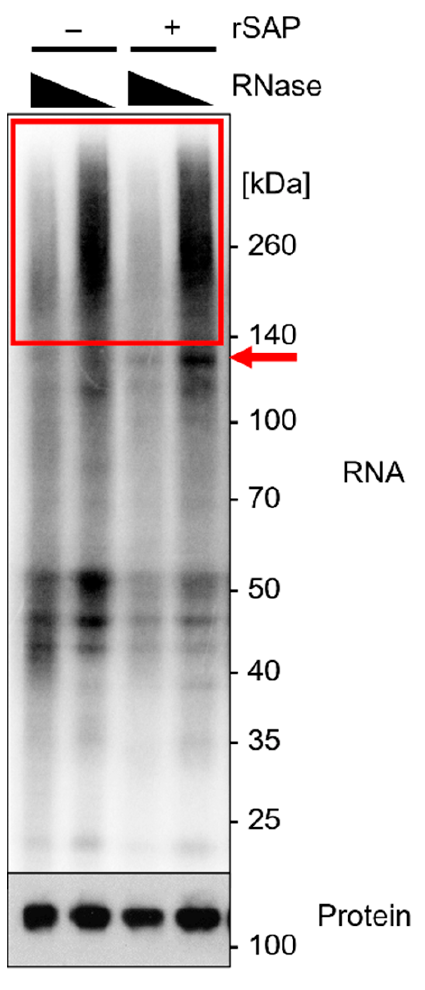
Figure 5. Analytical approach of Ago2-iCLIP2. Radiography of expected results on NuPAGE gel using protein marker VI (pre-stained) peqGOLD. A volume of 10 µ L of sample was loaded, the gel was run for 90 min at 200 V, and transferred to an Amersham Protran 0.45 µ m NC nitrocellulose membrane for 1 h at 30 V. The sample was subsequently exposed to a Fuji BAS-SR2040 imaging plate overnight. Calu3 cells were crosslinked at 254 nm with 450 mJ/cm 2 and lysed by sonication in 4 × packed cell volume lysis buffer. IP with 0.5 µ g α -Ago2 clone 11A9, RNase I digest employing dilutions of 10 − 3 and 10 − 5 , and with or without 5 (cid:48) end dephosphorylation using rSAP before radioactive labeling with ATP mix (1/2 volume [gamma-32P]-ATP). The red box indicates the area of interest with an RNase I concentration-dependent Ago2-bound RNA smear. The red arrow indicates Ago2-miRNA–mRNA complexes, which are more pronounced after 5 (cid:48) end dephosphorylation. Subsequent Western blot analysis of protein levels of Ago2 on CLIP-membrane, with 1:500 α -Ago2 clone 11A9 as primary antibody in 5% milk-TBS-T and 1:10,000 α -rat IgG-HRP as secondary antibody. Visualization on Amersham Hyperfilm ECL